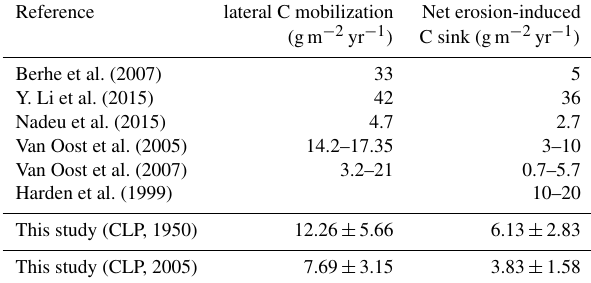
Table 3. Comparison of our estimates of the average lateral SOC mobilization rate and net erosion-induced carbon sequestration rate on the CLP with published rates for other